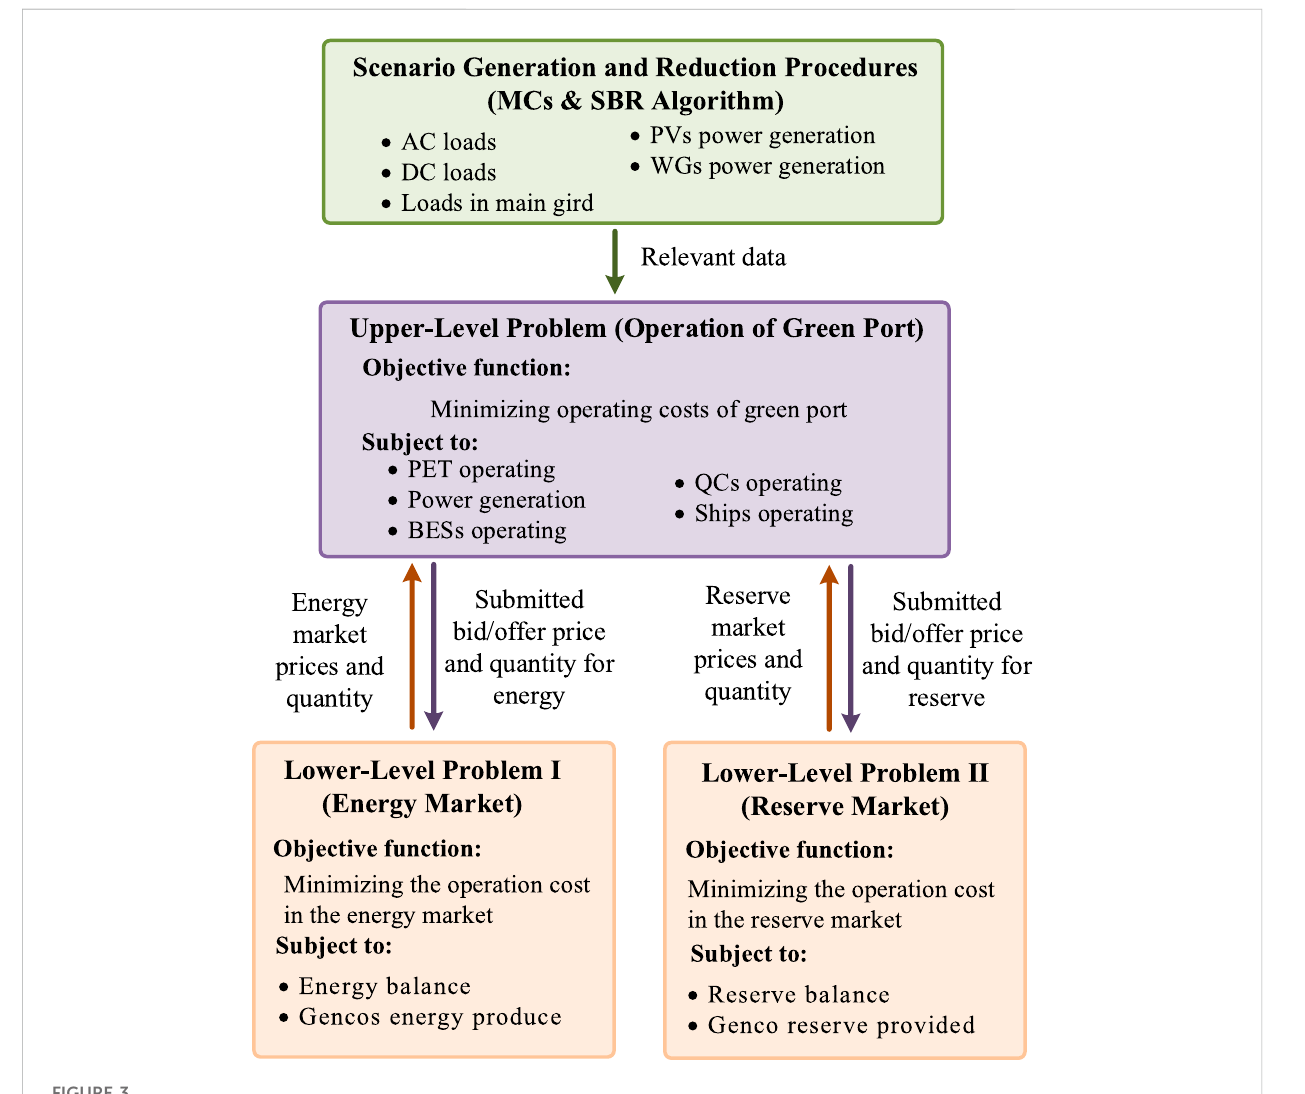
FIGURE 3 Structure of the bi-level stochastic optimization